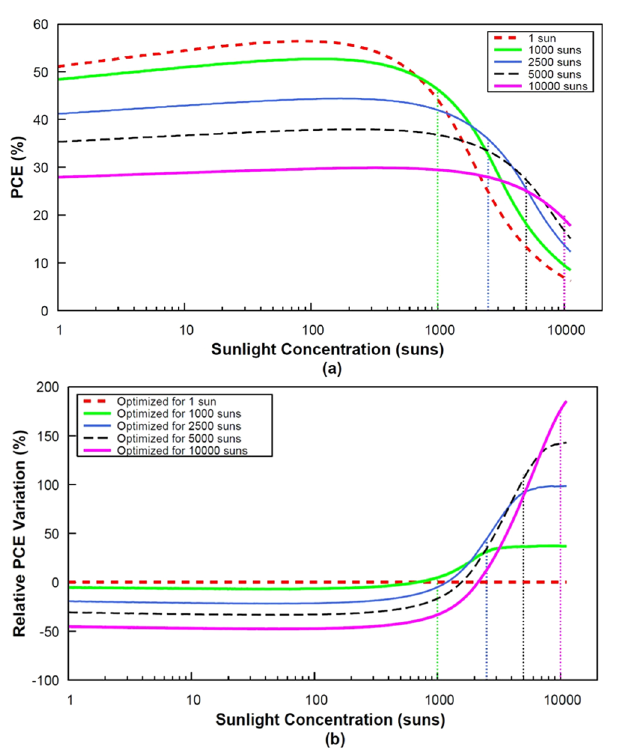
Figure 7. PCE ( a ) and relative PCE variation ( b ) as a function of sunlight concentration for 3-J cells with a total series resistance of 0.05 Ω cm 2